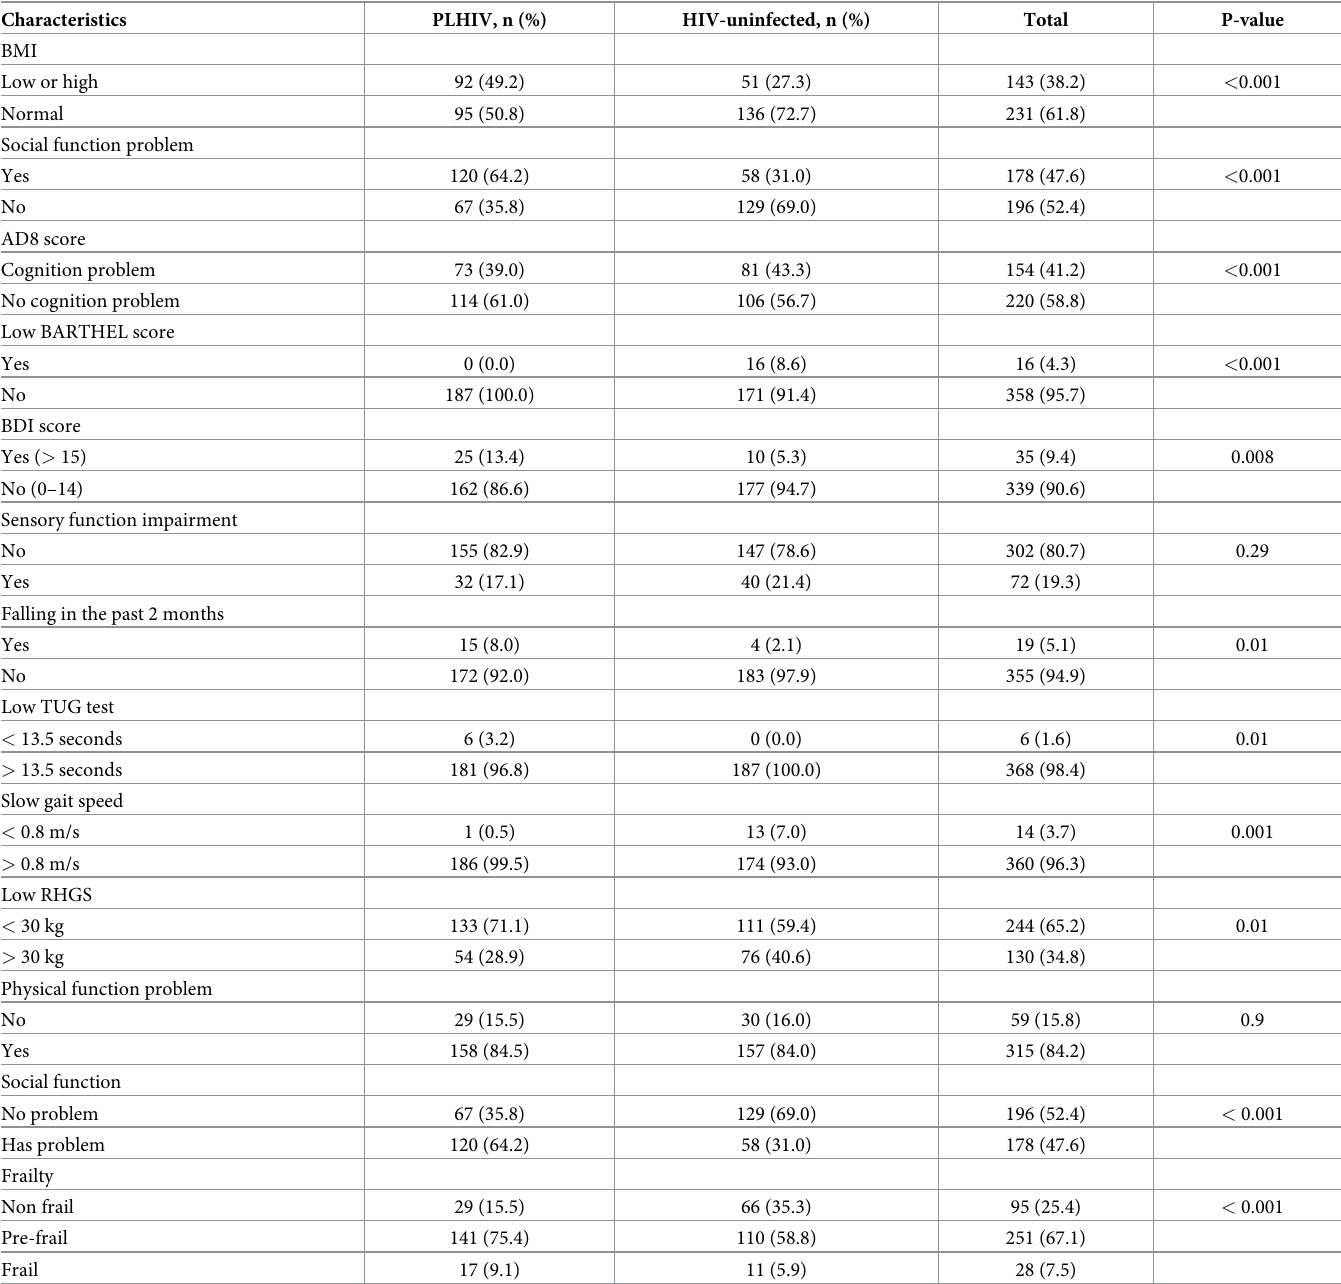
Table 2. Difference in frailty and its components measures among PLHIV and HIV negative controls.